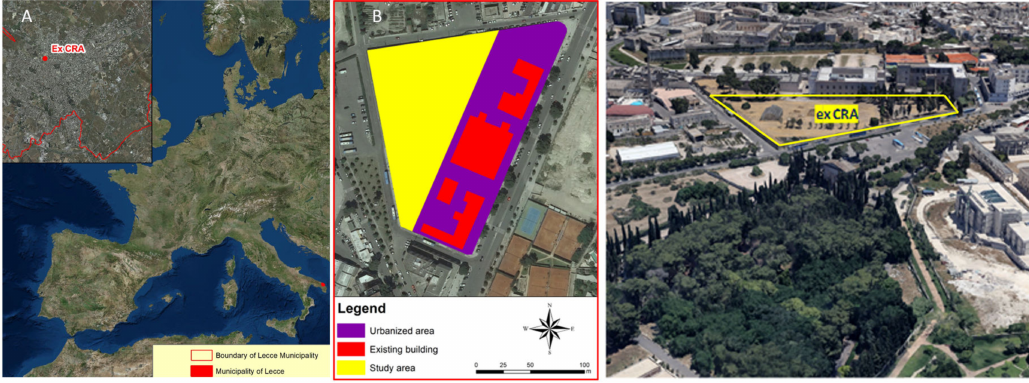
Figure 2. ( A ) Municipality of Lecce and location of the study area; ( B ) study area with reference to the context of the former Agricultural Research Center (ex